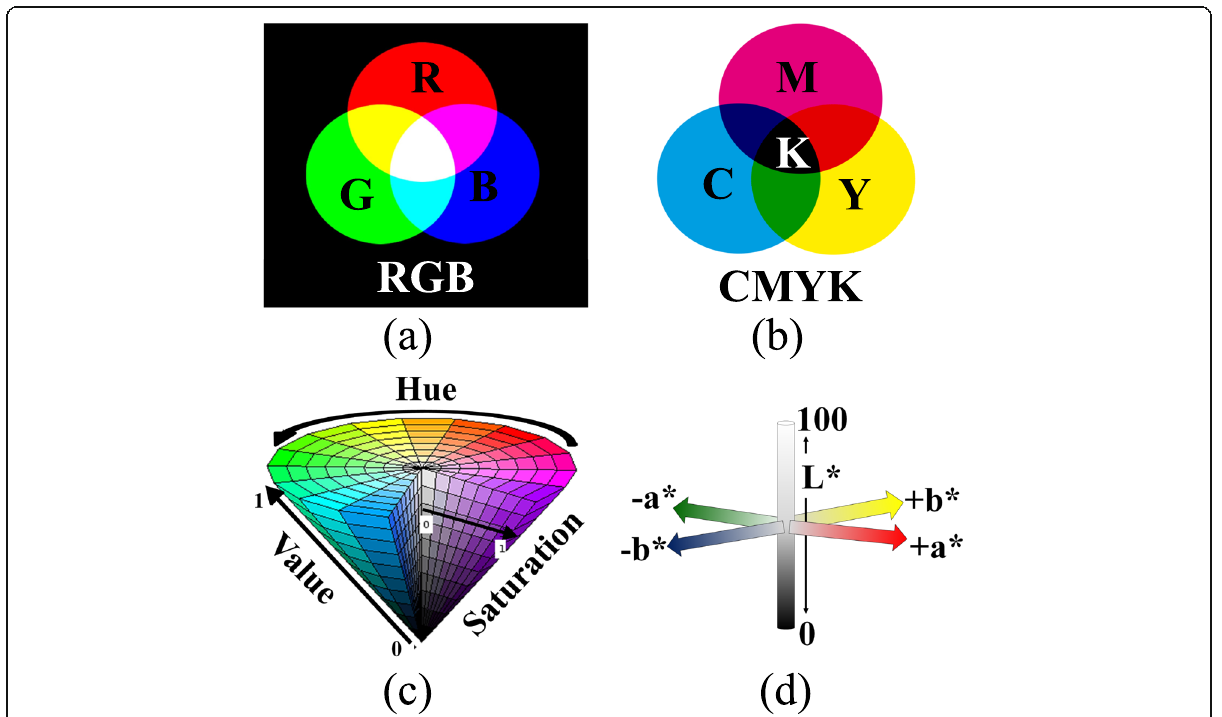
Fig. 1 Schematic diagram showing the difference among the a RGB, b CMYK, c HSV, and d CIELAB color